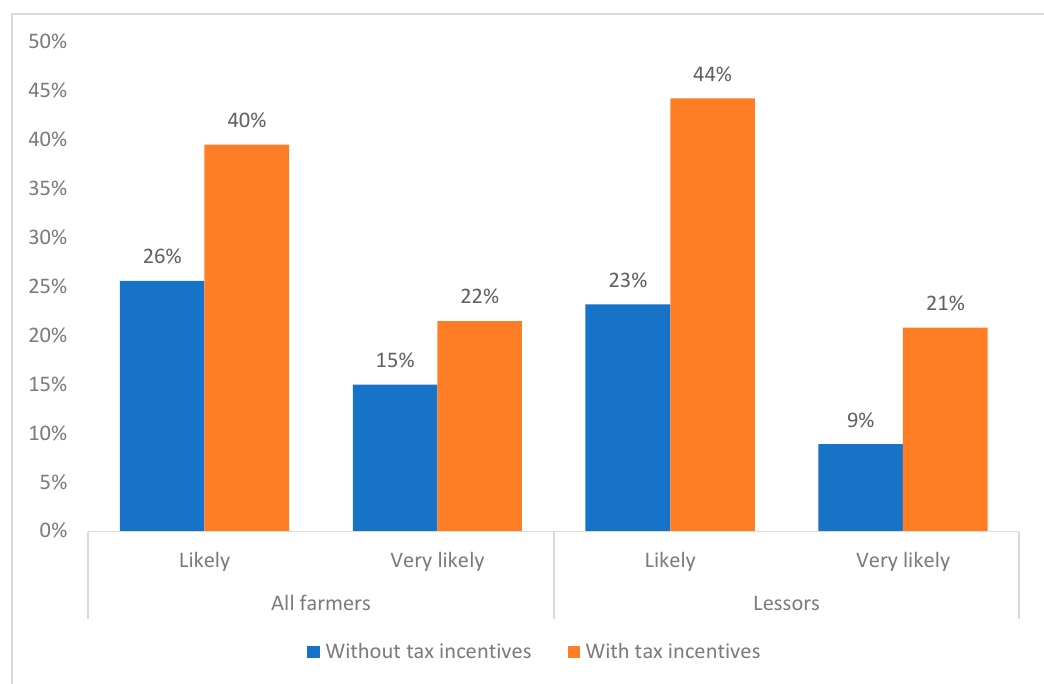
Figure 2. Intention to take up long-term land leasing with and without tax incentives.